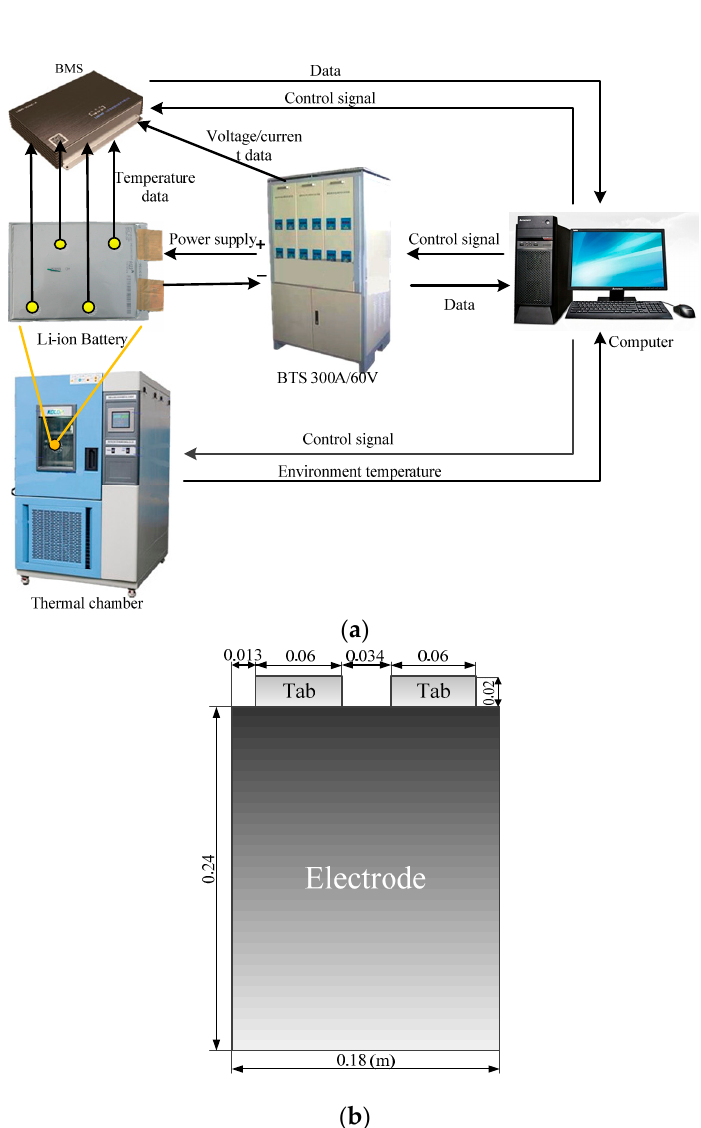
Figure 4. ( a ) Experimental platform and its schematic diagram of the signal and data flow; and ( b ) dimensions of electrodes and positions of the tabs of a 60 Ah LIB.